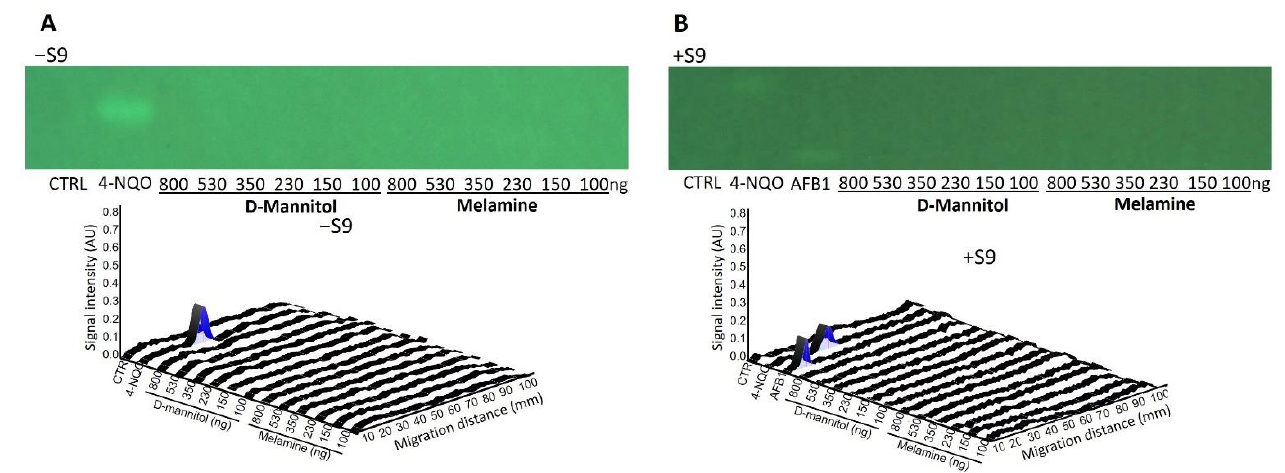
Figure 4. Bioautograms at FLD 254 nm (region of interest shown) and biodensitograms at 485/>500 nm showing the negative controls D-mannitol, melamine (100 − 800 ng/band each), and with the positive control 4-NQO (500 pg/band) ( A ) in absence ( − S9) and ( B ) in presence (+S9) of metabolic activation.